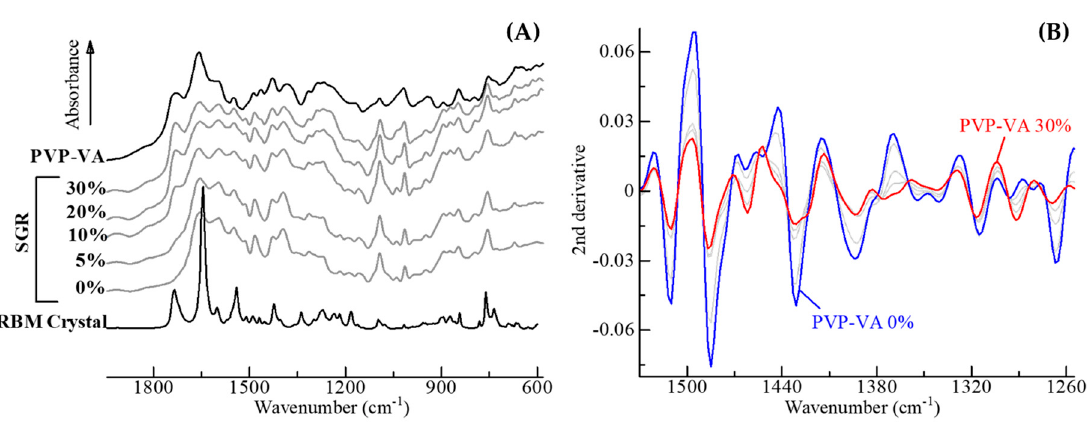
Figure 7. ( A ) Overlays of IR spectra of RBM crystals alone, PVP-VA alone, and SGR granules including 0 − 30% PVP-VA. ( B ) Representation of the second derivatives of SGR granules.